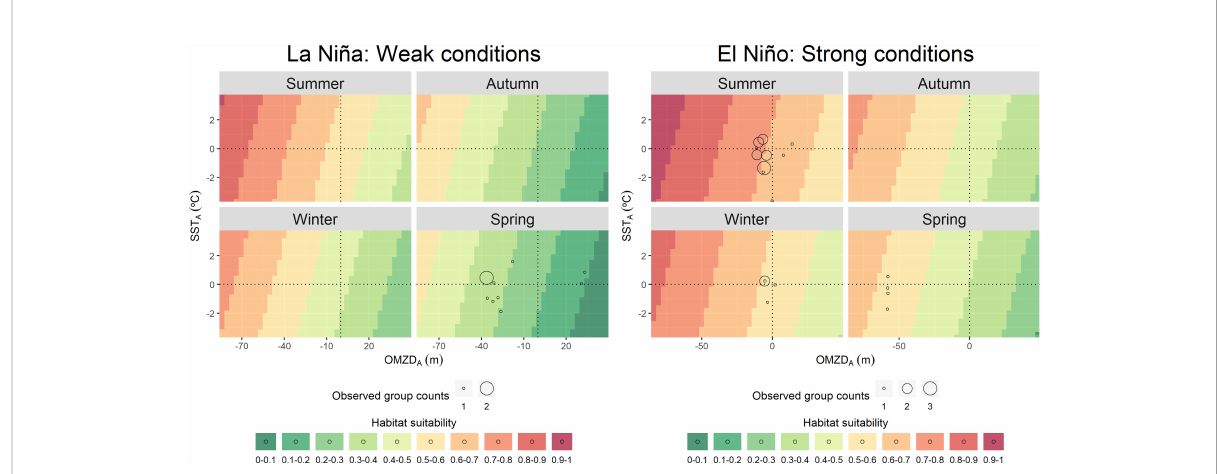
FIGURE 4 Predicted values of bottlenose dolphin ( Tursiops truncatus ) habitat suitability for a theoretical environmental space during La Niña and El Niño conditions, based on the covariates included in the best model: the oxygen minimum zone depth spatial anomaly (OMZD A ) and the remotely sensed chlorophyll- a concentration spatial anomaly (CHL A ). Empty circle sizes represent the observed group counts in each sample unit (i.e.,